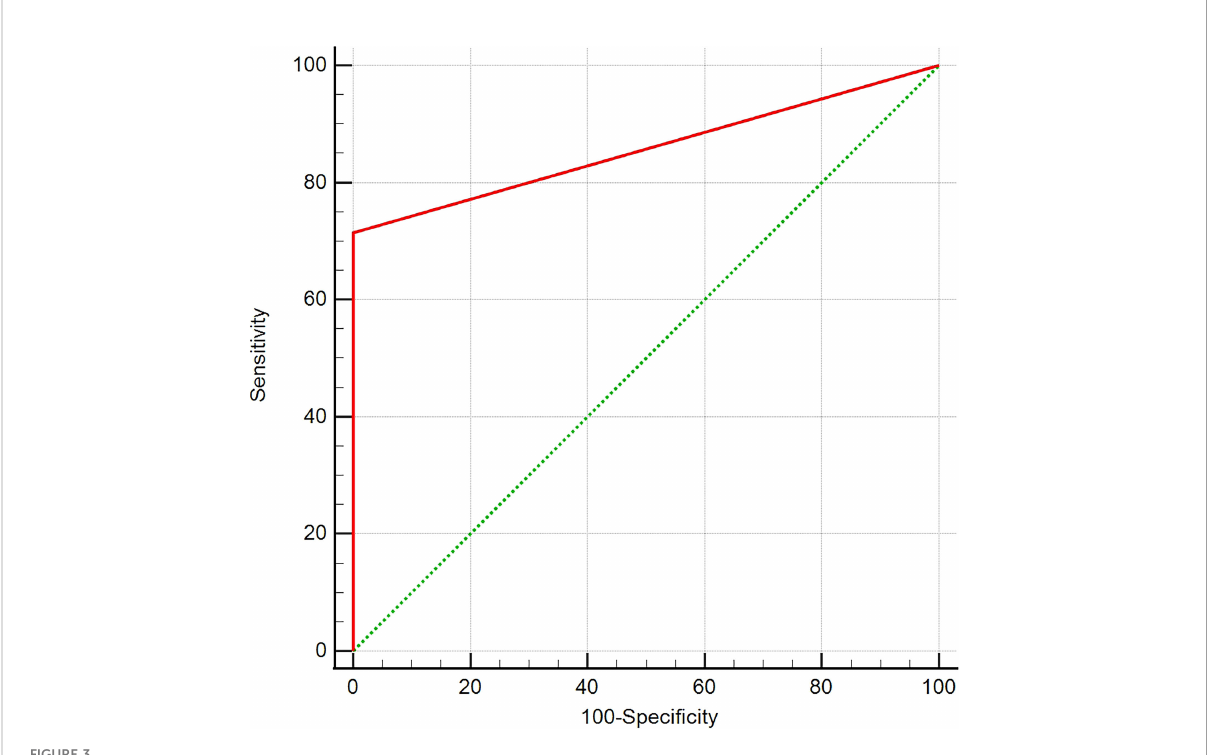
FIGURE 3 ROC curve analysis. The analysis of ROC curve reveals that EPPHS has diagnostic value in diagnosis of pituitary macroadenoma.